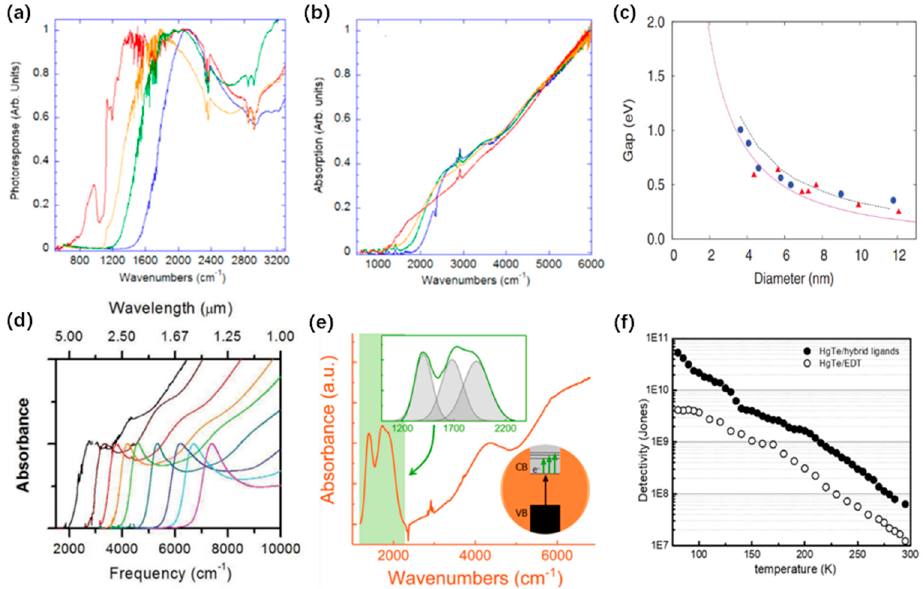
Figure 7. ( a ) Photo-response of thin films of HgTe QDs on a Si/SiO 2 substrate. Samples were made with different temperatures of 100 °C (blue), 110 °C (green) and 120 °C (orange). The red-line sample was obtained with a regrowth. Reprinted with permission from Ref. [90]. Copyright 2014 American Chemical Society. ( b ) Absorption spectra of thin films of HgTe QDs with the same color scheme as in ( a ). Reprinted with permission from Ref. [90]. Copyright 2014 American Chemical Society. ( c ) Energy gap of spherical HgTe QDs (300 K) versus diameter (magenta solid line) compared to the experimental data of Ref. [97] (red triangles) and Ref. [98] (blue disks). The black-dotted line represents the energy of the second peak in the calculated absorption spectrum. Reprinted with permission from Ref. [91]. Copyright 2012 American Physical Society. ( d ) Absorption of solutions of HgTe CQDs in C 2 Cl 4 . Reprinted with permission from Ref. [88]. Copyright 2011 American Chemical Society. ( e ) Spectrum of N-doped HgTe QDs indicates that doping leads to intraband absorbance and restrains the first two excitonic transitions. The green box illustration shows that the total absorption spectrum profile is composed of three small overlapping absorption spectra. The illustration with the orange background shows intra and interband transitions. Reprinted with permission from Ref. [95]. Copyright 2018 American Chemical Society. ( f ) Detectivity as a function of temperature for the HgTe/hybrid and HgTe/EDT films. Reprinted with permission from Ref. [96]. Copyright 2019 American Chemical